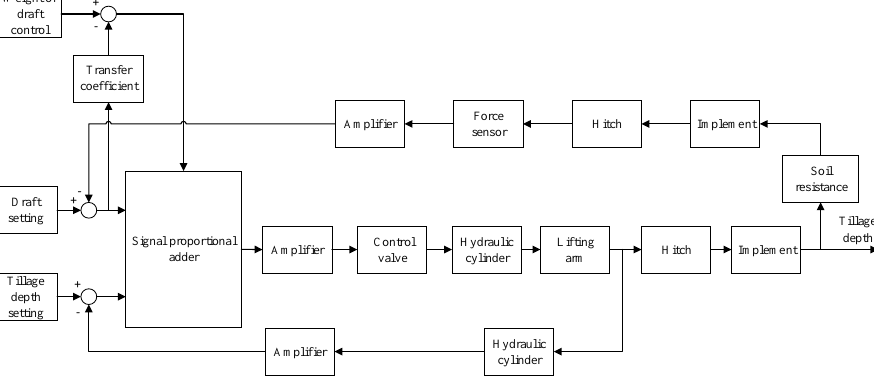
Figure 3. Mixed draft − position adjustment scheme with variable weights.